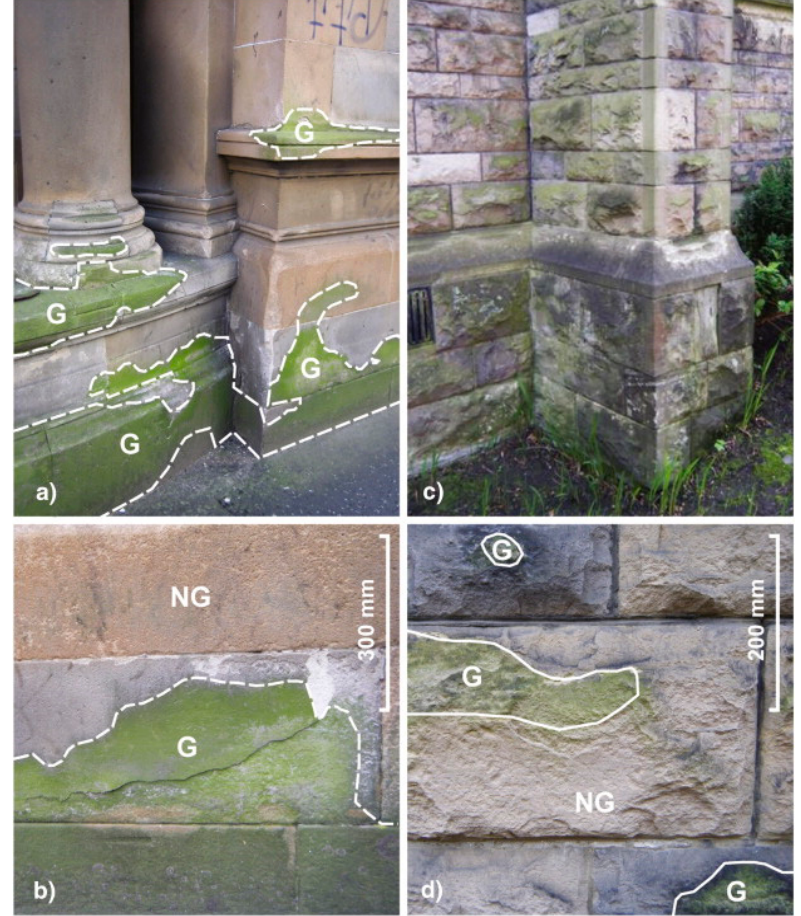
Figure 3. Examples of colonization by green algae. The green algal patches are demarcated using dotted/solid lines and labelled ‘G’: ( a ) the ashlar walls of Ewart’s building in Belfast, ( b ) details of an ashlar block in Giffnock stone from the same building, ( c ) the rock-faced walls of All Souls Church in Belfast, ( d ) detail of a rock-faced, Scrabbo block from All Souls Church in Belfast. Reprinted from Science of the Total Environment, 442, N. A. Cutler, H. A. Viles, S. Ahmad, S. McCabe, B. J. Smith, Algal ‘greening’ and the conservation of stone heritage structures, 152–164, Copyright (2013), with permission from Elsevier.